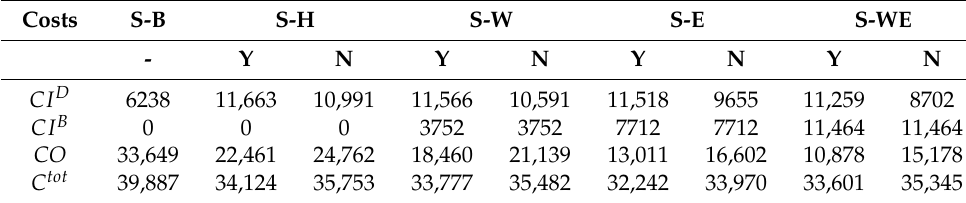
Table 7. Optimal investment and operation